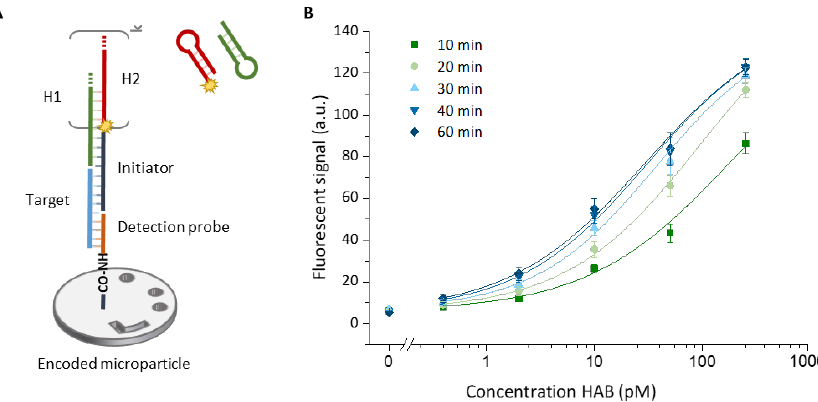
Figure 2. ( A ) Schematic representation of the assay build-up. First, the target (light blue) is captured by the detection probe (orange), which is immobilized on the surface of an encoded microparticle. After capturing the target, the polymerization of two metastable hairpin structures, called H1 (green) and H2 (red), is initiated by the initiator probe (dark blue). The length of the resulting nicked ds-DNA construct (i.e., the amount of signal amplification) depends on the number of HCR cycles (k) that increase over time. ( B ) Calibration curves obtained for the detection of the HAB target (250, 50, 10, 2, 0.4 pM and blank) by employing different durations of the HCR ranging from 10 to 60 min. Error bars indicate one standard deviation ( n = 3).